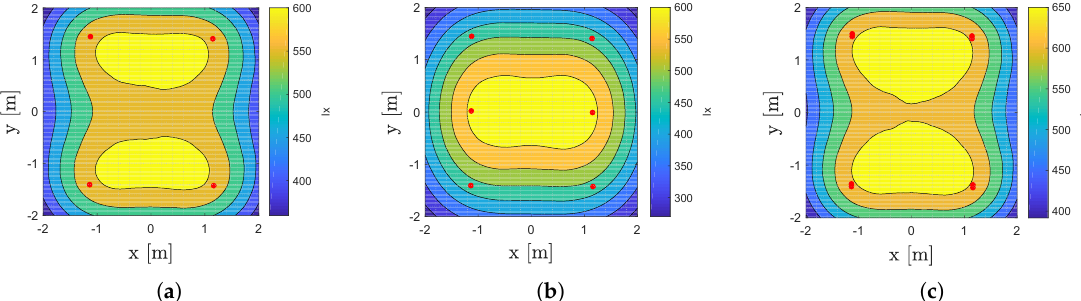
Figure 16. Illuminance distribution in the virtualised lab setup ( a ) during uVLP operation, ( b ) during VLP with 6 LEDs on 2 rails and ( c ) during VLP with 8 LEDs where an additional LED is placed 5 cm north from each of the original LEDs.